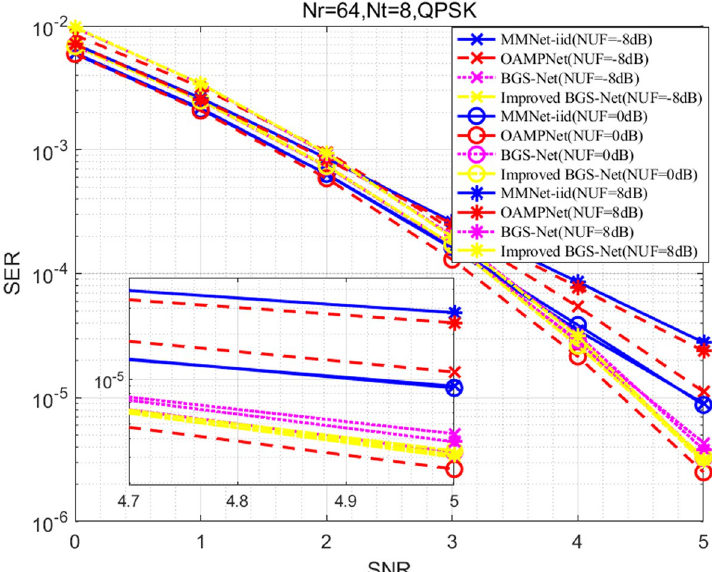
Fig. 31 SER performance of the proposed detection algorithm when there is noise estimation error in an uplink multi-user massive MIMO system, where N t = 8,N r =